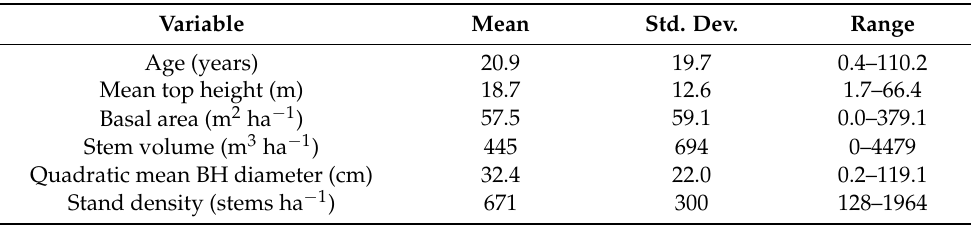
Table 1. Summary of data from 743 measurements in 179 permanent sample plots used to fit the redwood growth model. Variable Mean Std.